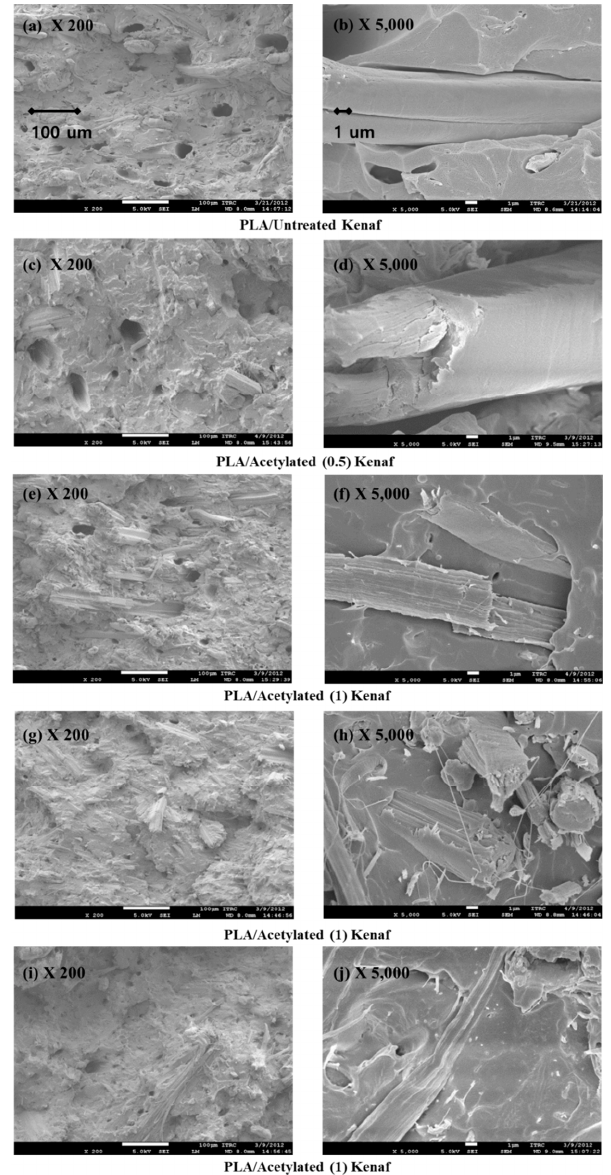
Figure 5. Field Emission Scanning Electron Microscopy (FESEM) micrographs of flexural fractured surfaces of flexural specimens of untreated and acetylated kenaf–polylactic acid (PLA) composites.